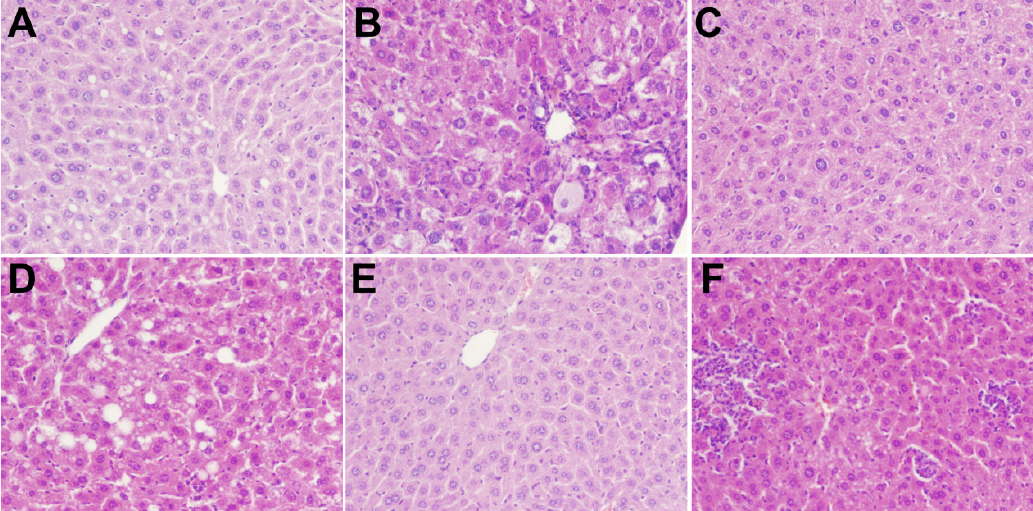
Figure 4. Effects of MBP on histopathological changes in liver: NC group ( A ), DM group ( B ), MET group ( C ), MBP-100 group ( D ), MBP-200 group ( E ), MBP-400 group ( F ).